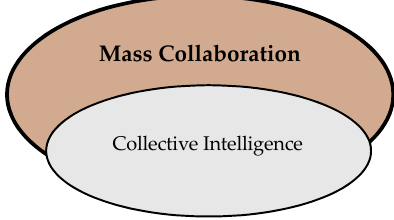
Figure 1. Relationship between mass collaboration and collective intelligence.